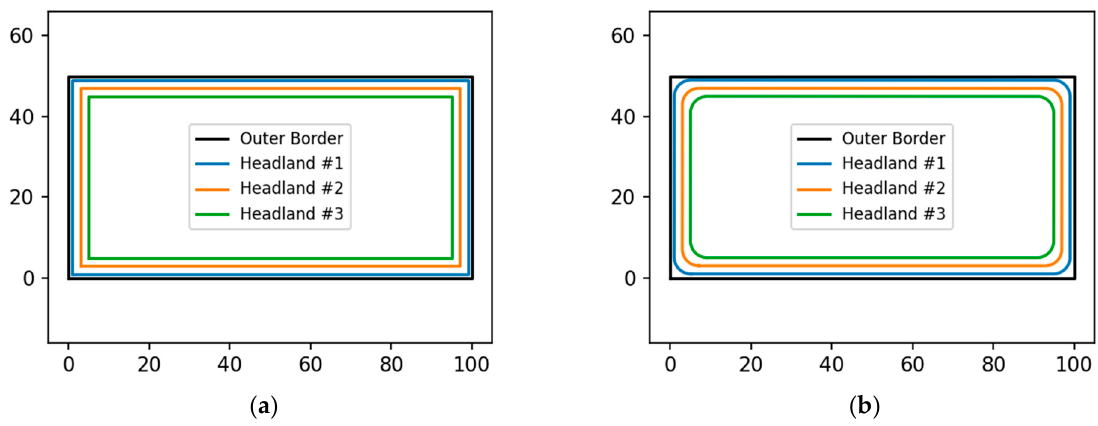
Figure 5. (a ) 3 headland passes on a rectangular subfield; (b) 3 headland passes on a rectangular Figure 5. ( a ) 3 headland passes on a rectangular subfield; ( b ) 3 headland passes on a rectangular subfield with the corresponding tractor turning radius. subfield with the corresponding tractor turning radius.